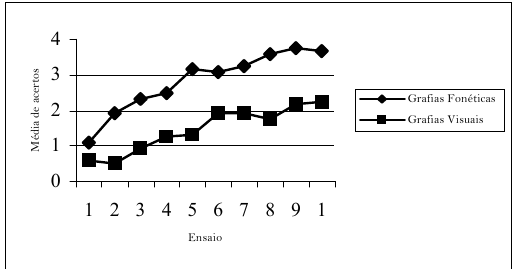
Figura 1 . Indivíduos com conhecimento do nome das letras: número médio de repostas corretas por ensaio em função do tipo de